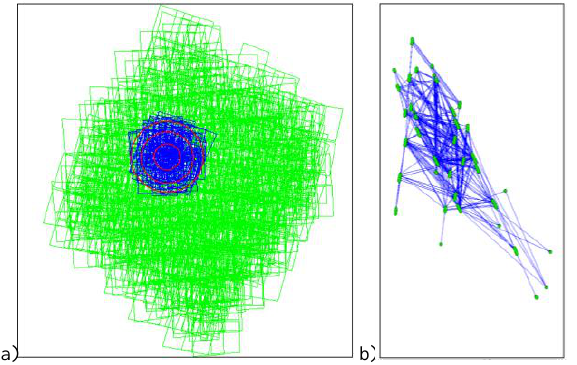
Figure 4: Image concatenation of an aerial block acquired with a fan system (VisionMap A3): ROI selection (a) and connectivity graph complying with conditions A, B and C